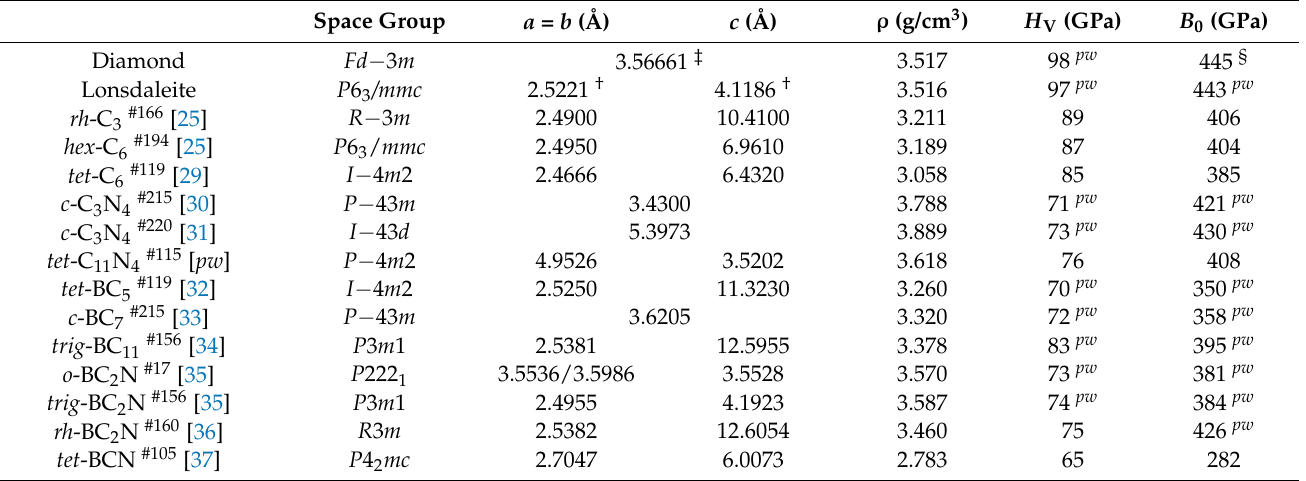
Table 1. (Ultra)hard phases of the B–C–N system: lattice parameters, density ( ρ ), Vickers hardness ( H V ) and bulk moduli ( B 0 ) calculated in the framework of thermodynamic model of hardness [27]. Space Group